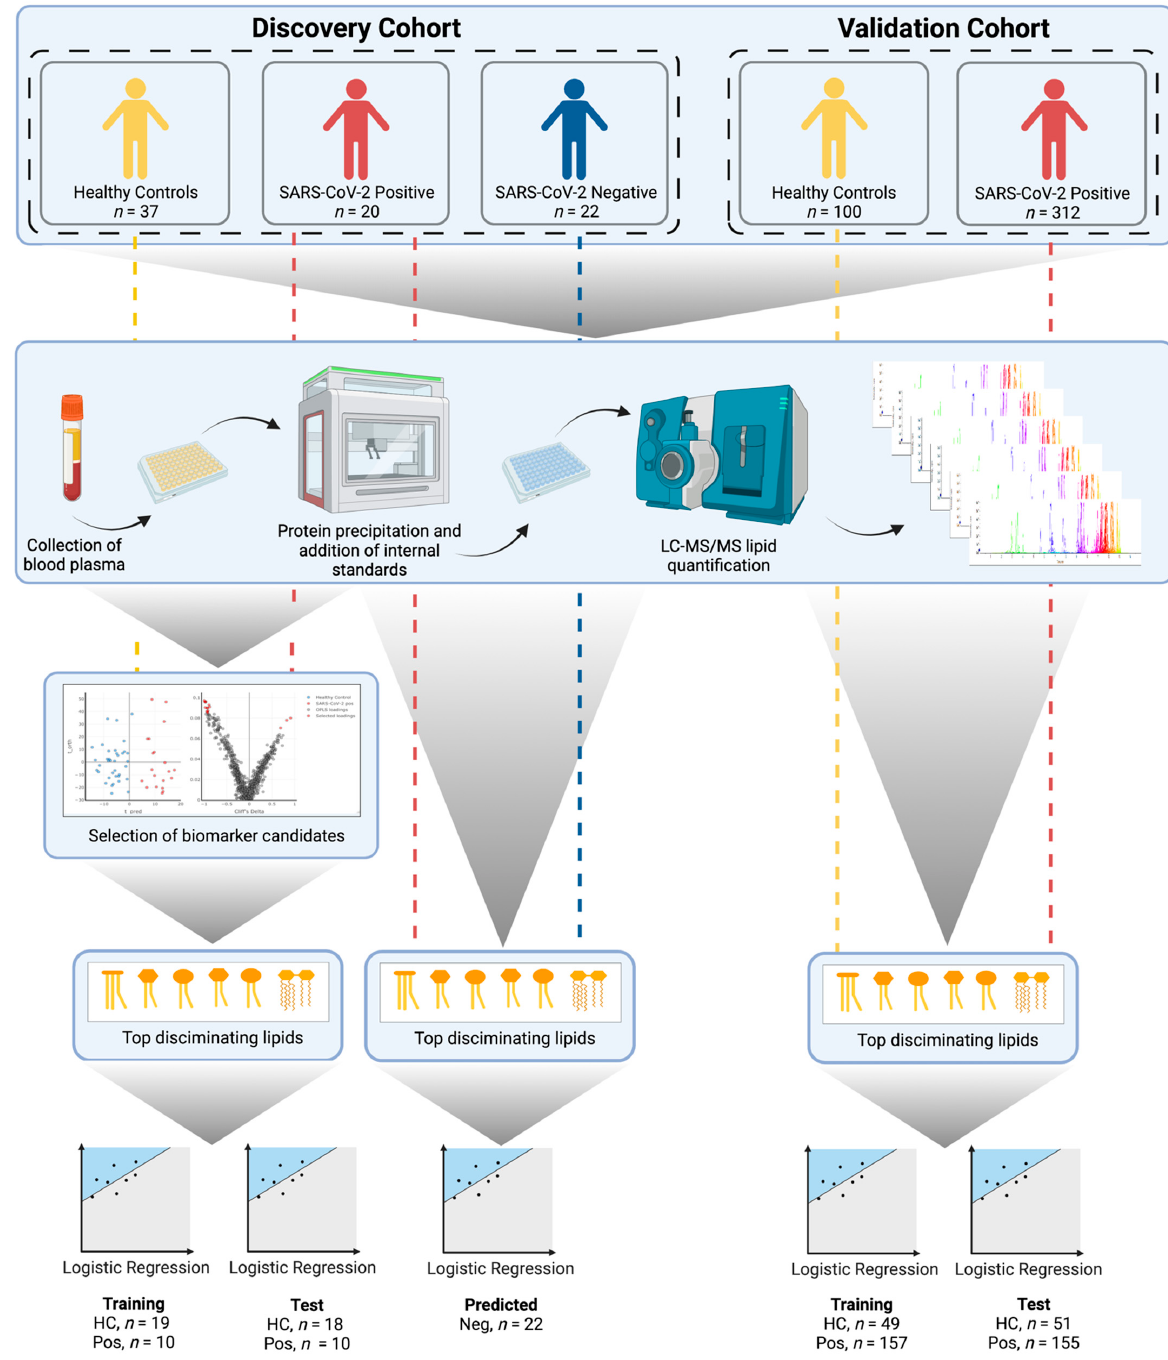
Figure 1. Experimental design of the study (created with BioRender.com, accessed 9 June 2021). First, lipidomic data were acquired using LC–MS. The acquired data from the discovery cohort underwent multivariate OPLS-DA modelling to facilitate the selection of biomarker candidates. A six-lipid classifier was built using logistic regression. The classifier was validated using a training/test study design, applied to two orthogonal sample collections (discovery and validation). For the discovery cohort, samples collected from individuals reporting COVID-19-like symptoms, but who tested negative for the SARS-CoV-2 virus, were projected onto the logistic regression classifier in order to evaluate the ability to differentiate between SARS-CoV-2 and other upper respiratory tract infections.